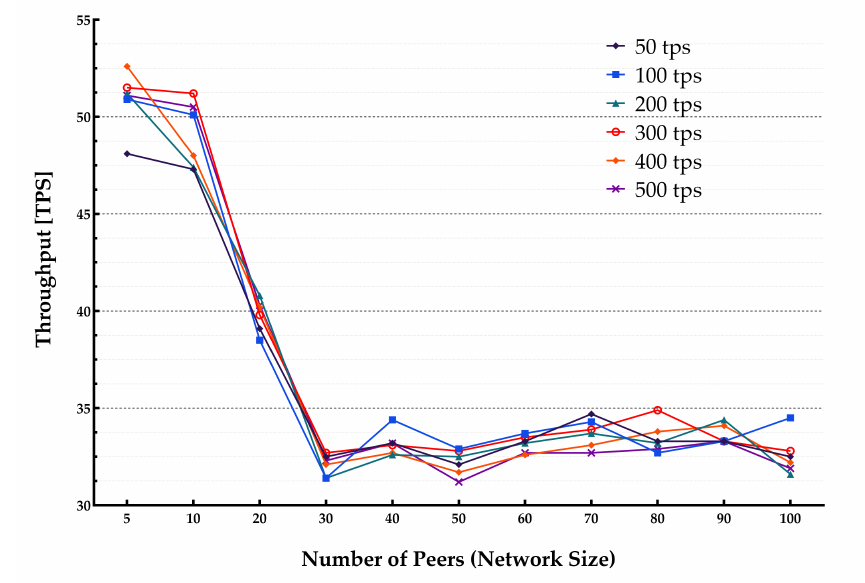
Figure 13. Impact of network size on the system throughput.